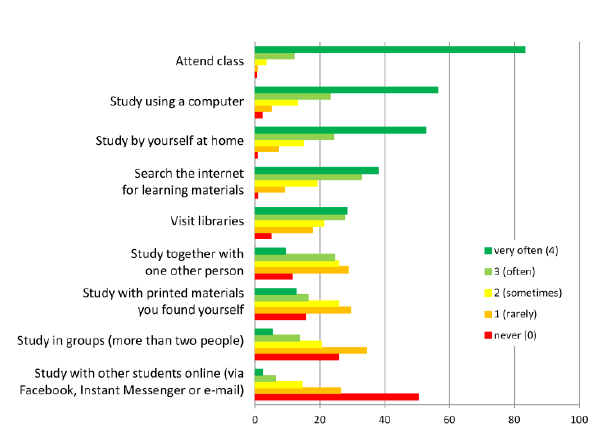
Figure 3: The valid percent of students’ responses to the question: How often do you do the following?